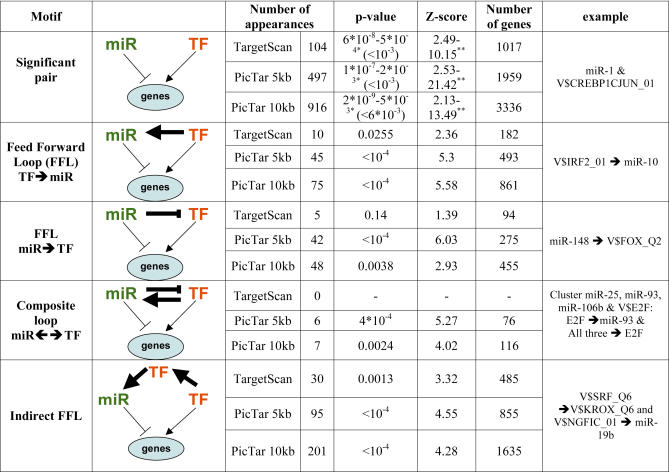
Network Designs in the miR–TF Coregulation NetworkThe figure depicts the analyzed network motifs in the TargetScan and PicTar dataset, and with the use of TF binding sites in RefSeq genes promoters of 10 kb for both networks, and 5 kb for the PicTar network. The figure depicts, for each network motif, its architecture, the number of times it appears in each of the networks, the p-value and z-score for its over-representation in the network (as described in Materials and Methods), the total number of RefSeq genes that are regulated by this type of network design, and an example.*For the first design, the coregulating miR–TF pair, we state the range of hypergeometric p-values of pairs that passed FDR and are considered significant, and in brackets the FDR p-value of these pairs using the randomization co-occurrence test.**In addition, z-scores for significant pairs were calculated based on the co-occurrence edge-swapping randomization model (see Materials and Methods).